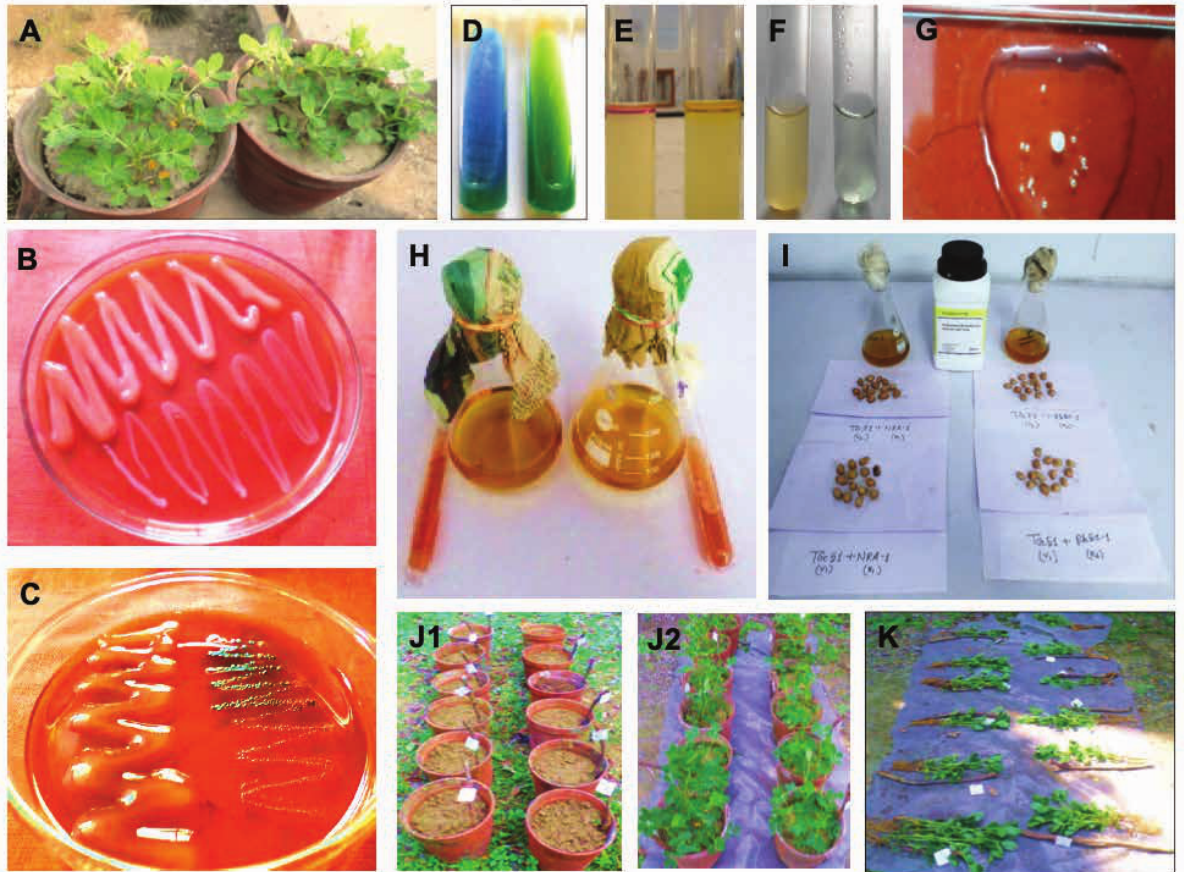
Figure 1: (A) Groundnut ( Arachis hypogaea L.) varieties TG 51 (left) and TG 71 (right) were grown in separate pots to isolate